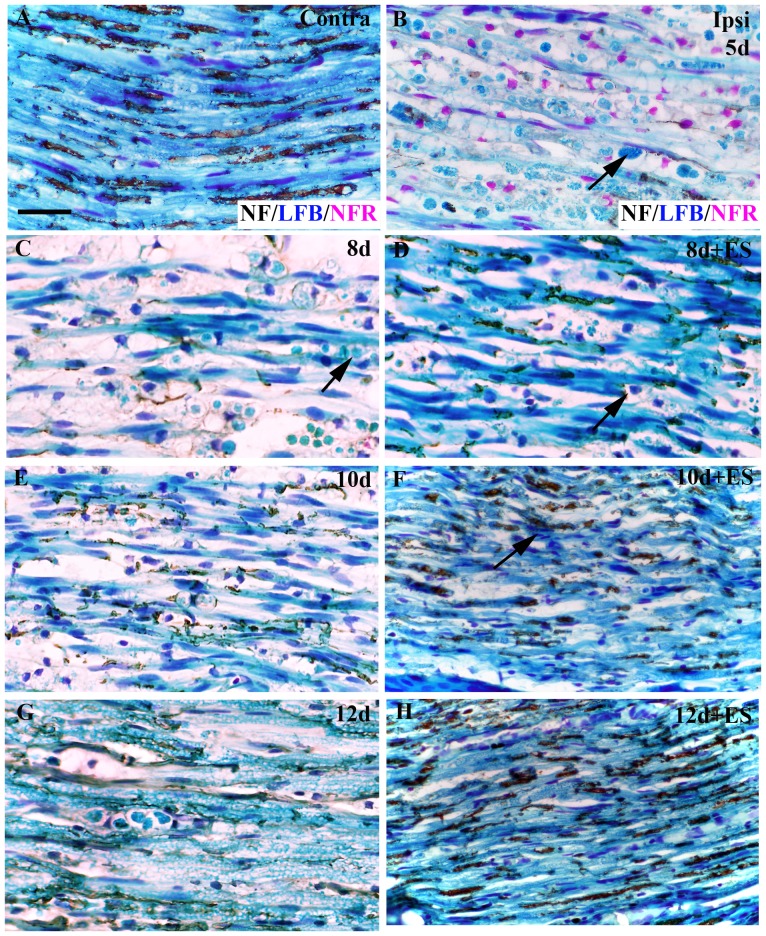
Neurofilament expression increases coincident with reappearance of myelinated axons in demyelinated nerves subjected to ES.Representative photomicrographs from FluoroGold (FG)-positive (i.e.focally demyelinated) areas of longitudinal tibial nerve sections immunostained for neurofilament proteins (NF – brown/black) then stained for the presence of myelin (Luxol Fast Blue [LFB] - blue) and nuclei (nuclear fast red [NFR] – purple/darkblue). Uninjured (contralateral) control tibial nerves displayed intense uniform LFB staining, indicative of abundant myelin with prominent linear NF immunostaining (A) and elongated dark blue Schwann cell nuclei. Five days post tibial nerve injection of lysophosphatidyl choline (LPC)/FG, extensive NF and myelin loss is observed coupled with infiltration by numerous macrophages filled with largely unprocessed myelin debris (B,C arrow). Temporal analysis of LPC-focally demyelinated nerves +/- ES as indicated in days post-LPC. Note: In the LPC+ES group there was increasing linear NF immunoreactivity detected (F,H) with higher levels of uniform LFB staining consistent with myelinated axons, and the appearance of macrophages devoid of myelin debris apparent as early as 8d post-LPC (3d post-ES; D, arrow). The LFB staining was even stronger in the 10d (5d post-ES) animals where presumptive Schwann cells now display elongated nuclei (F, arrow) and 12d (7d post-ES; H) post-ES tissue. In contrast, in the LPC only group there was just a slight increase in NF immunoreactivity beginning 10d post-LPC (E), but it was much less robust than that observed in the stimulated as well as the contralateral control nerves. Notably in the nonstimulated nerves the immune cell infiltration is still largely unresolved at the 12d post-LPC time point. Scale bar = 5 µm.